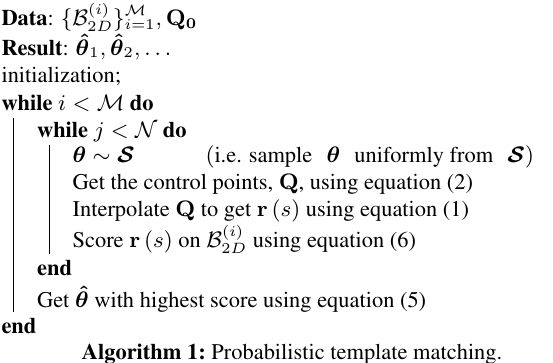
Algorithm 1: Probabilistic template matching.